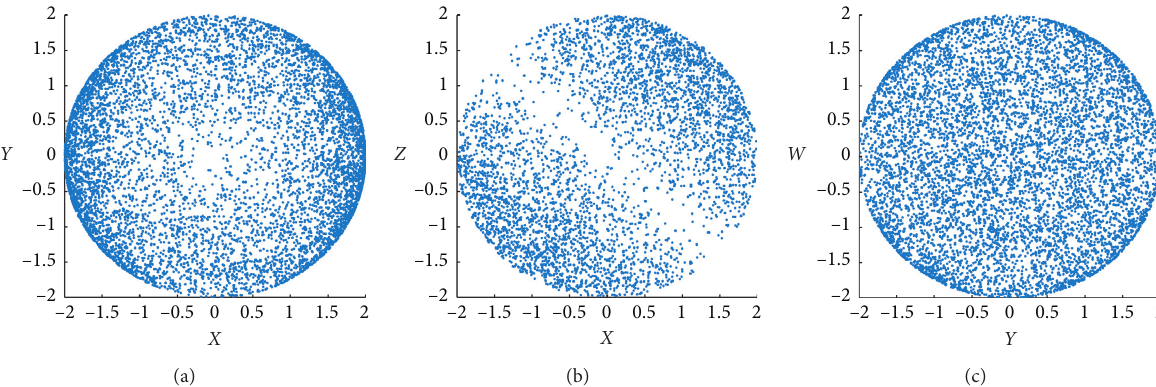
, y ,z , w ) � ( 1 , 1 , 1 , 1 ) . (a) x - y 0 0 0 0